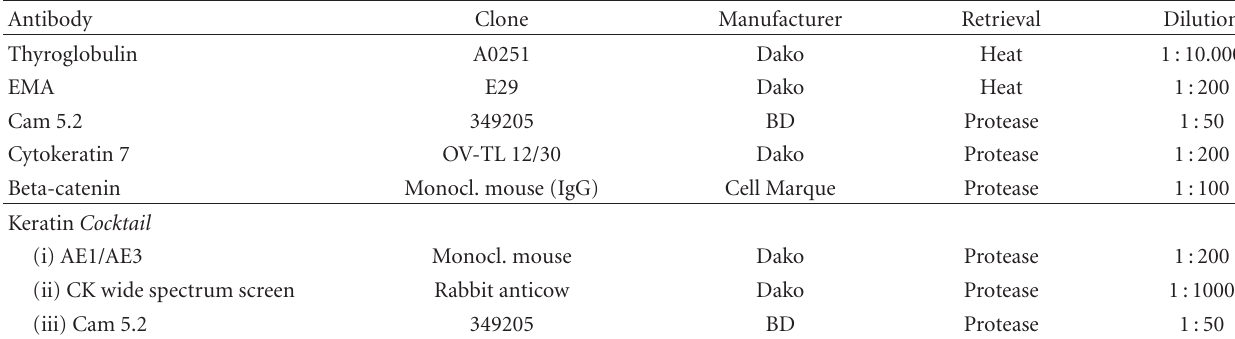
Table 1: Antibody